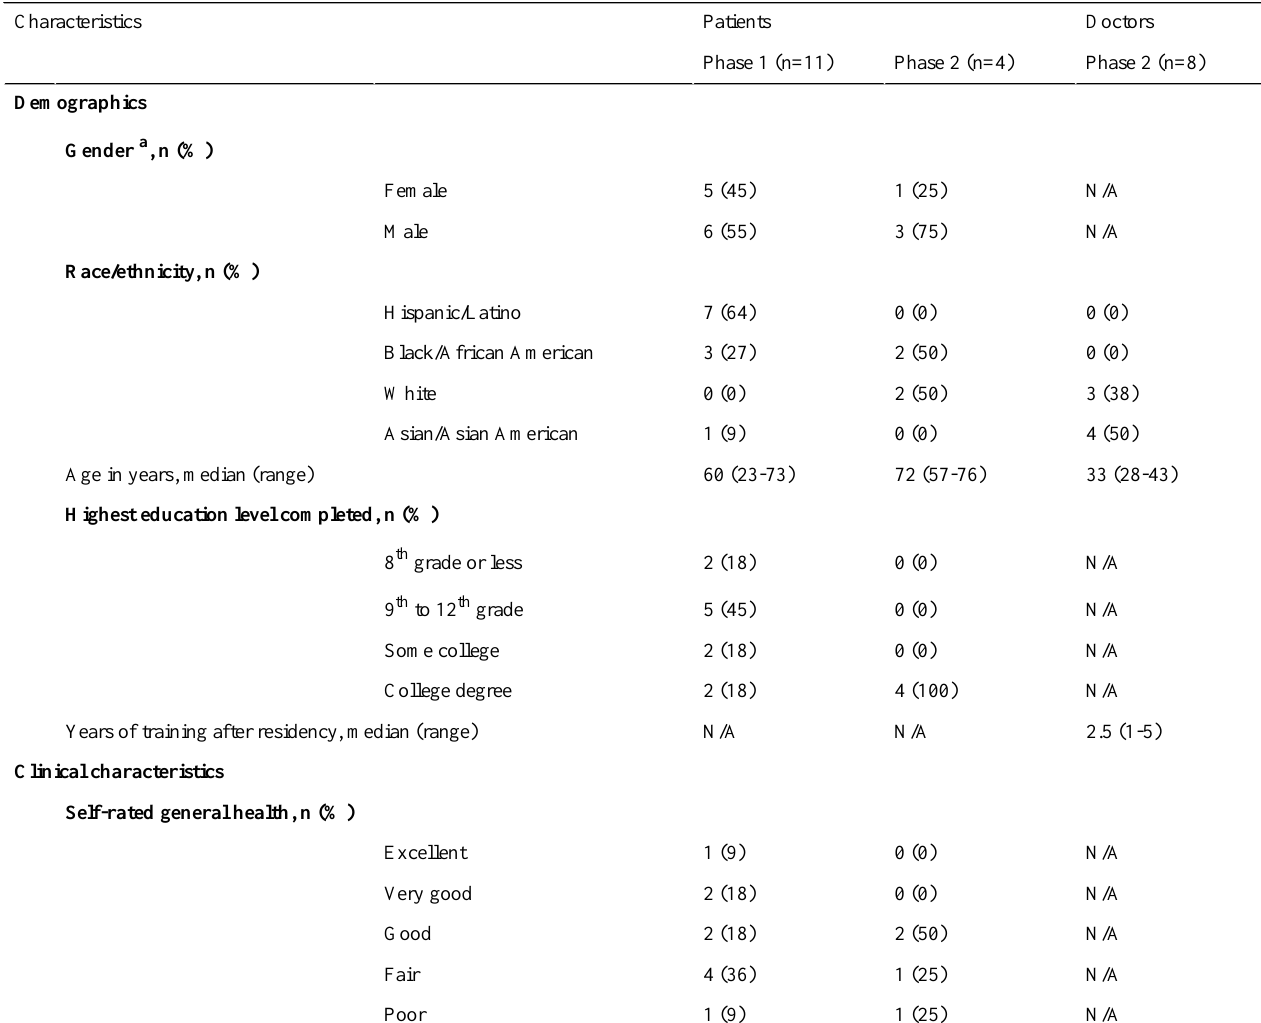
Table 1. Participant